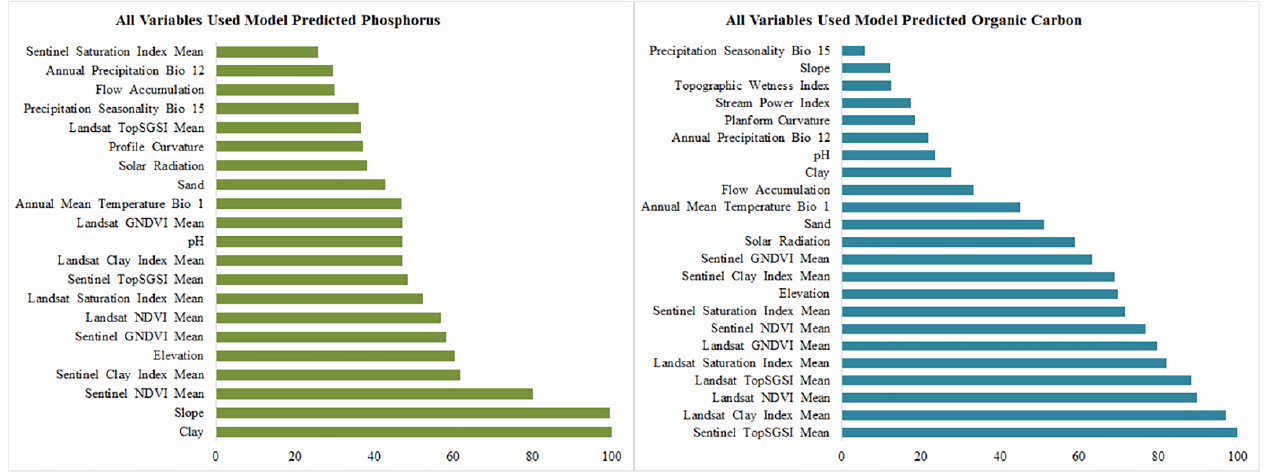
Figure 3. The importance level of environmental variables in the random forest model with recur- sive feature elimination (X axis: percent relative importance). feature elimination (X axis: percent relative importance).